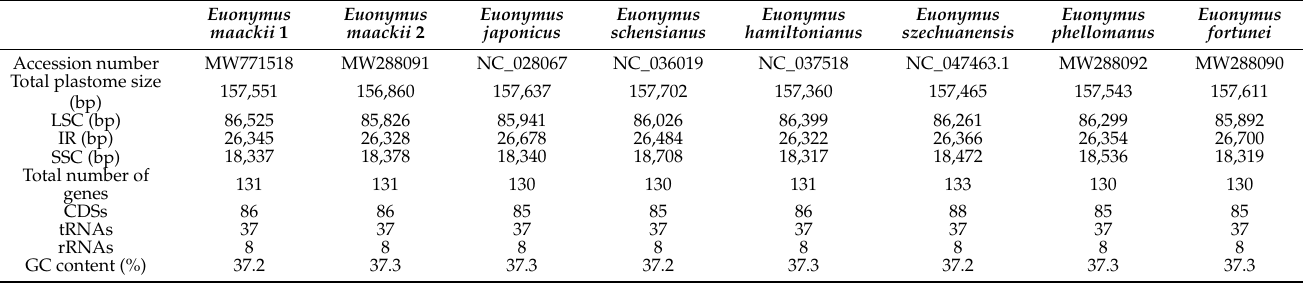
Figure 1. Map of the chloroplast genome of Euonymus maackii Rupr. Table 1. Comparison of the chloroplast genome features of Euonymus